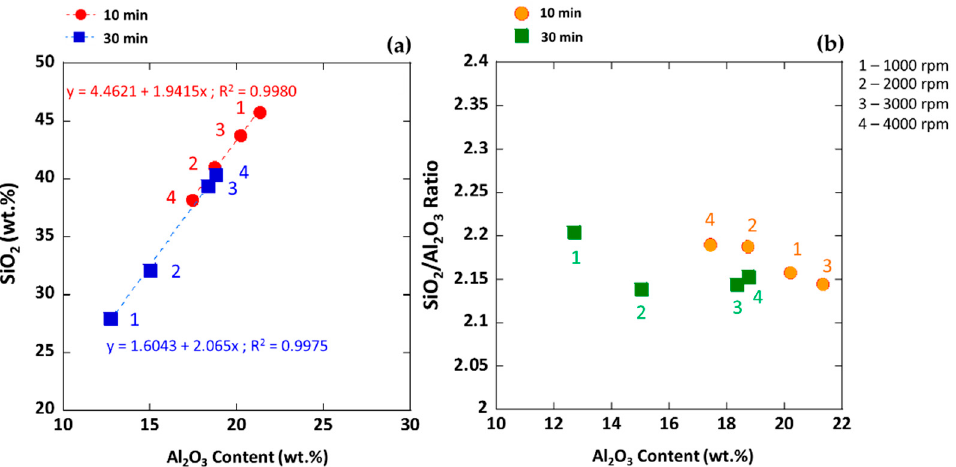
Figure 4. Histograms displaying chemical compositions of cenospheres plotted against centrifugal speed for the centrifugal times of ( a ) 10 min and ( b ) 30 min.